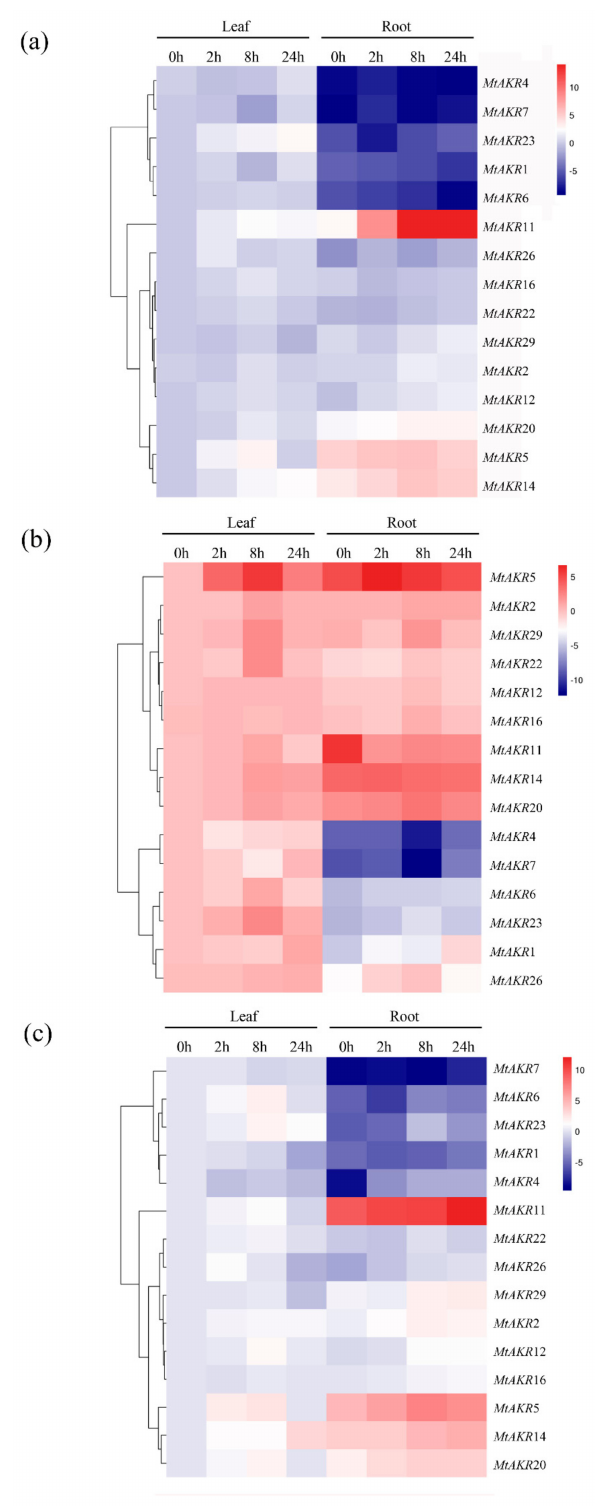
Figure 6. Hierarchical clustering and heatmap representation of leaf and root MtAKR genes expression profiles in ABA ( a ), PEG ( b ), and NaCl ( c ) conditions. The data obtained by quantitative RT-PCR correspond to the levels of MtAKRs in total RNA samples extracted from leaves and roots (four technical replicates). The expression levels of genes were used 2 − ∆∆ Ct , and the heatmap was presented in log 2